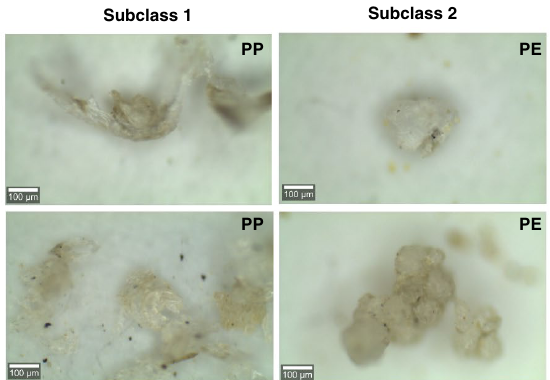
Figure 3. Semi-transparent plastic particles in subclass 1 (PP) and subclass 2 (PE).